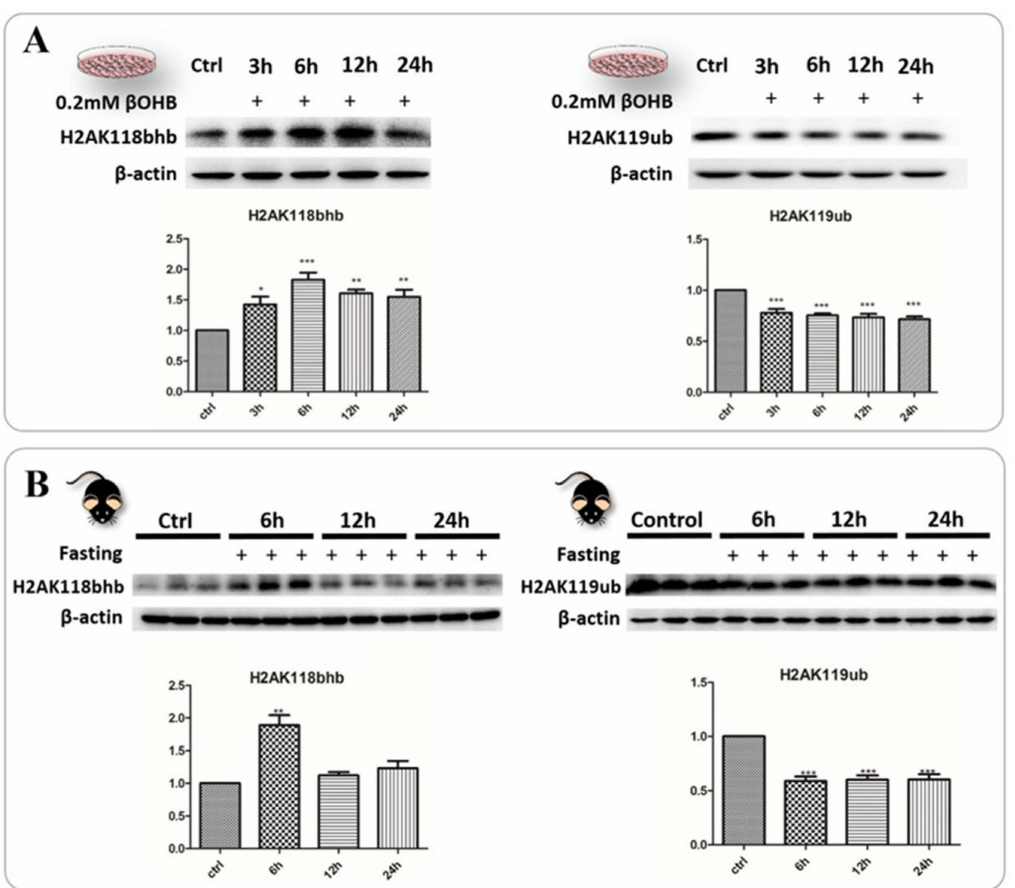
Figure 5. Identification and validation of abundant histone lysine hydroxybutyrylation (Kbhb) sites. ( A ) Western blot analysis ( n = 3), left, revealed that 3OHB induced a significant increase of H2AK118bhb levels in the HT22 cells (at 6 h ( p < 0.001), 12 h ( p < 0.01) and 24 h ( p < 0.01); right, H2AK119ub levels in the HT22 cells were significantly reduced after 3OHB treatment ( p < 0.001). ( B )Western blot analysis ( n = 6), left, showing that fasting induced a significant increase of H2AK118bhb levels in C67 mice at 6 h of fasting ( p < 0.01); right, H2AK119ub levels showed a similar pattern of significant reduction as observed in the HT22 cells ( p < 0.001). Data are mean ± SEM n = 3 ( A ), Data are mean ± SEM n = 6 mice per group ( B ), one‑way ANOVA, Tukey’s test, * means p < 0.05, ** means p < 0.01 while *** means p < 0.001 ( A , B